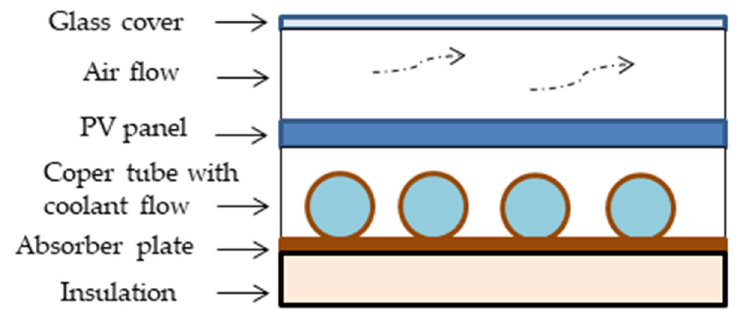
Figure 3. The cross-section of the PVT collector with water and air cooling systems adapted from